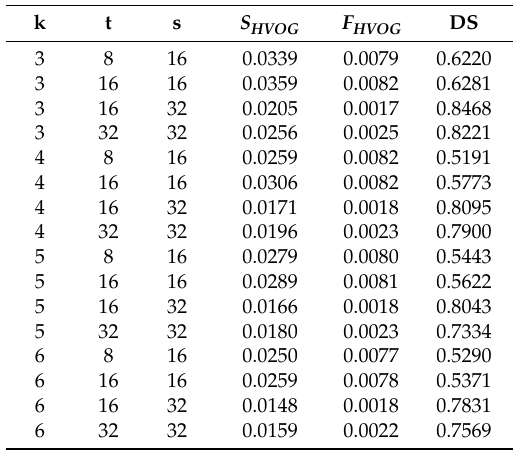
Table 1. The calculated DS values at different parameter values.